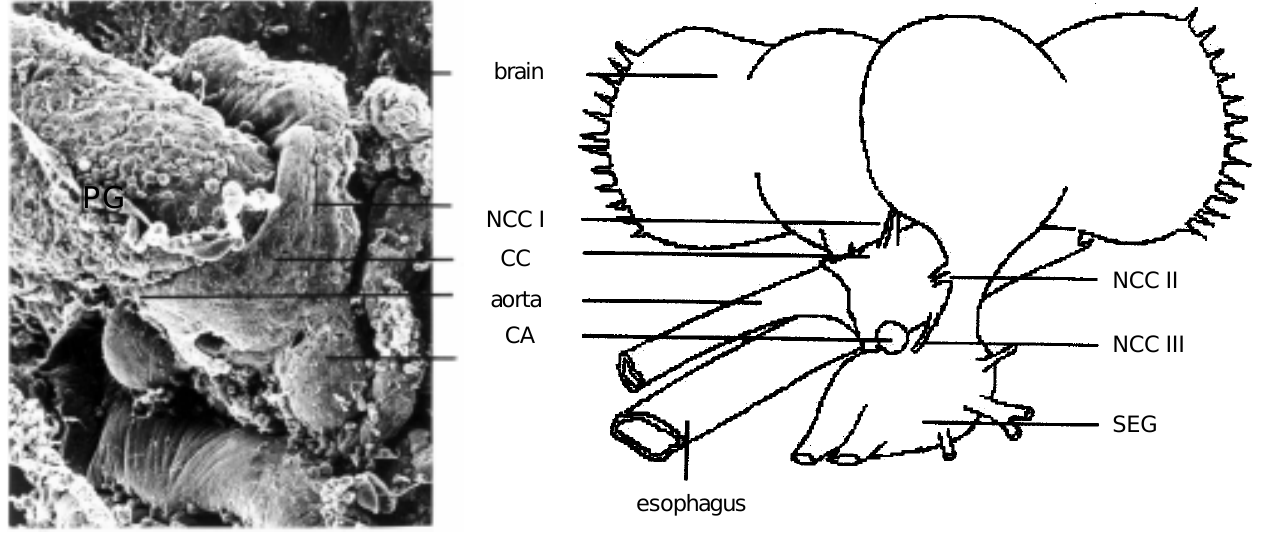
Figure 1 - The retrocerebral endocrine complex of insects as exemplified by the honey bee. SEM micrograph (left) of the corpora cardiaca and the juvenile hormone-producing corpora allata. The NCC is seen to cross the corpora cardiaca which are tightly connected to the aorta on top of the esophagus. Schematic drawing (right) of the brain and associated endocrine system of a honey bee pupa. Three pairs of nerves descend from different brain regions forming the brain-corpora cardiaca-corpora allata neuroendocrine axis. CA, Corpora allata; CC, corpora cardiaca; NCC I-III, nervi corporis cardiaci I-III, respectively; PG, string of prothoracic gland cells; SEG, subesophageal